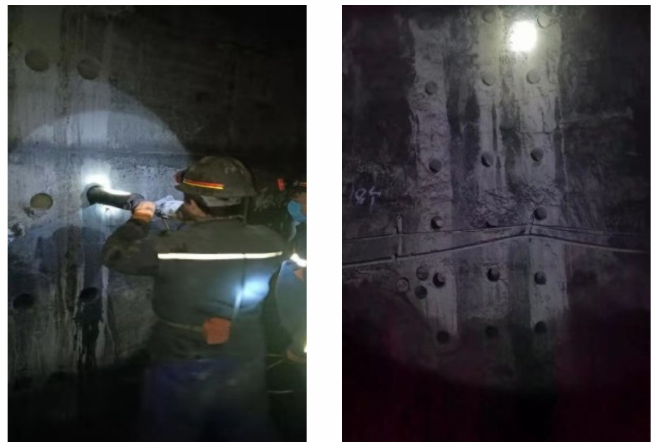
Figure 19. Sample drawing from working face.